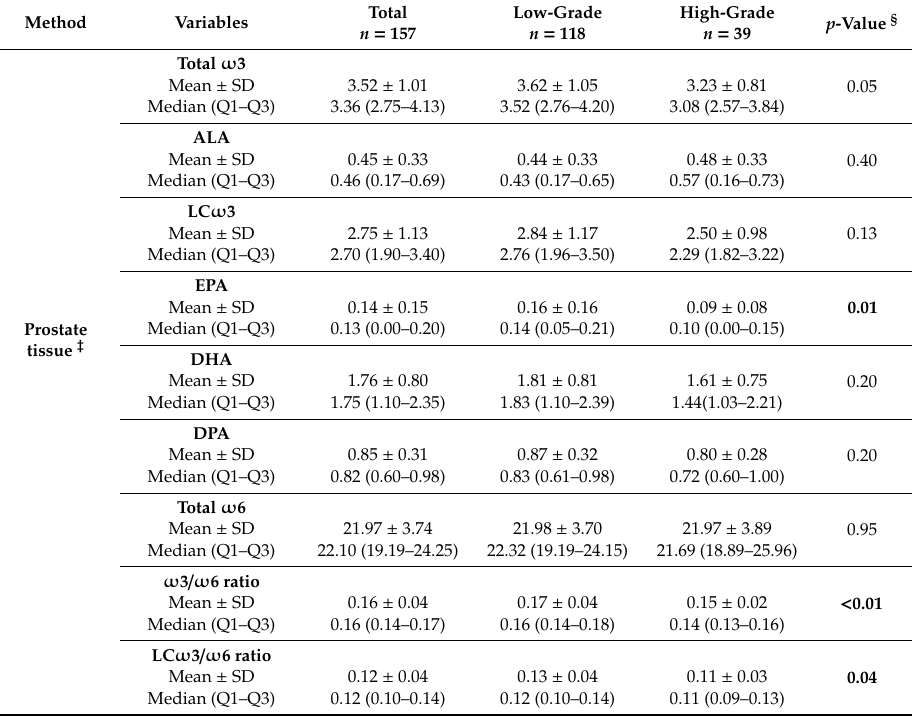
Table 6. We observed a similar direction of e ff ect of the LC ω 3 / ω 6 ratio measured in RBC than that measured in prostate tissue, but none of the RBC associations were significant (all p -trends > 0.20). Table 7. Contrasting with FA levels in RBC, men in the highest tertile of LC ω 3 intake had a decreased risk of high-grade PCa (adjusted OR 0.30; 95% CI 0.11–0.83; p -trend = 0.02) compared to men in the lowest tertile of LC ω 3 intake. A similar protective e ff ect was observed with a higher LC ω 3 / ω 6 ratio (OR 0.29; 95% CI 0.11–0.76; p -trend =